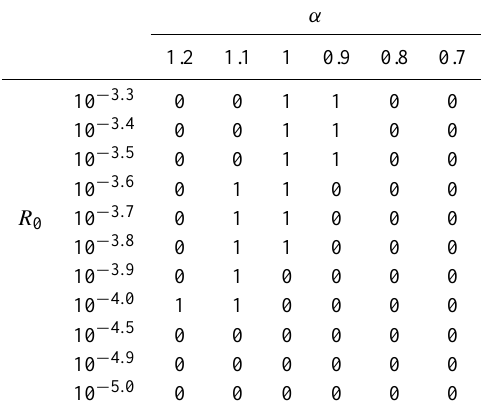
Table 8. Scorecard of all R 0 and α pairs for the case of 5 September 2012.